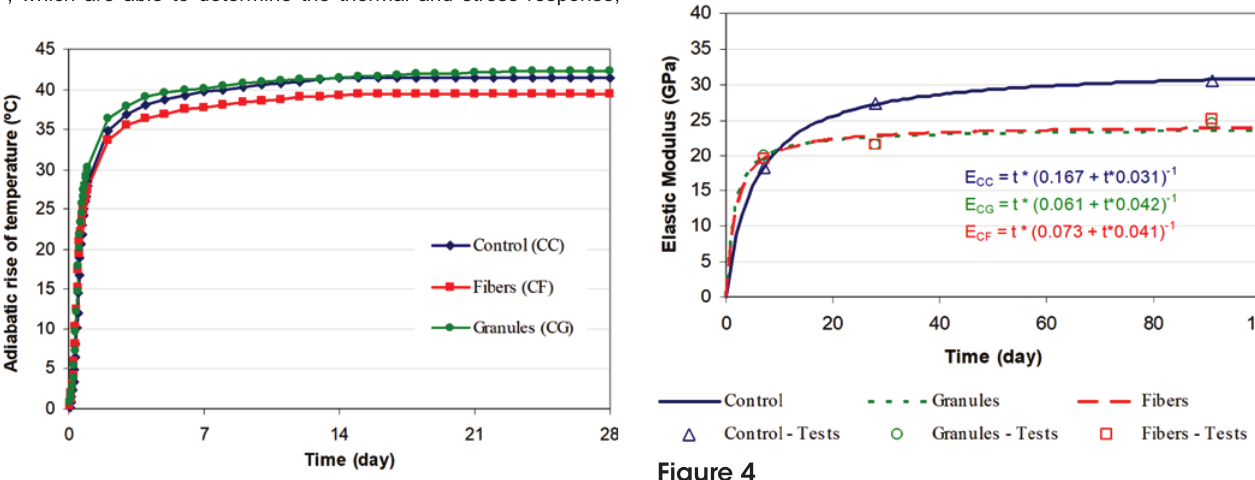
Adiabatic rise of temperature for each type of concrete